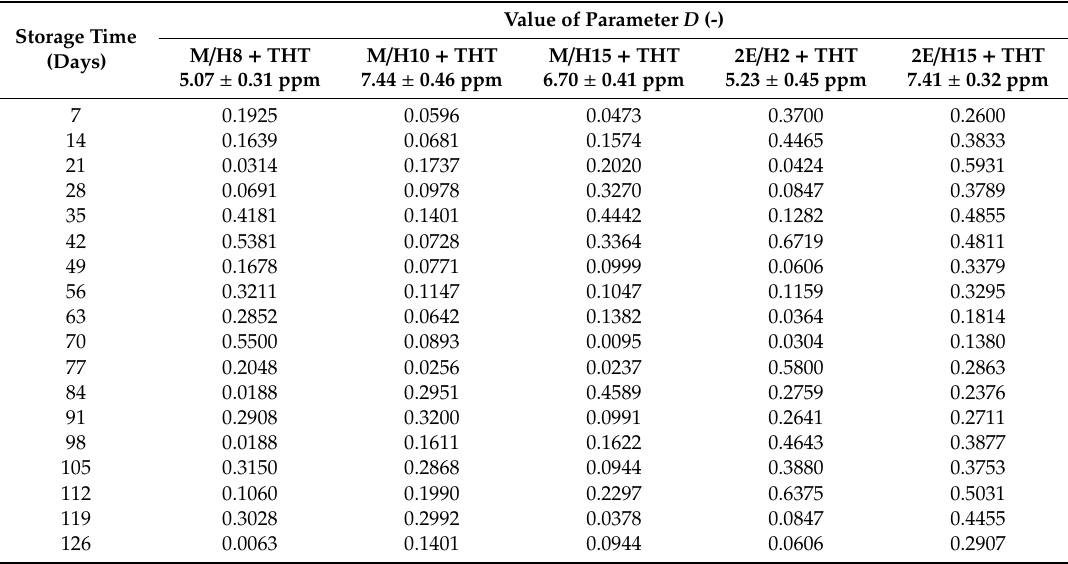
Table 4. List of the established values of the control parameter ( D ) for assessing the stability of M / H + THT or 2E / H + THT mixtures.